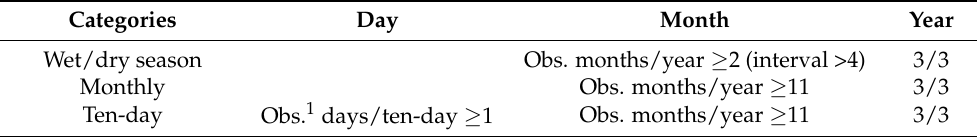
Table 1. Three categories of temporal coverage patterns and combined criteria.